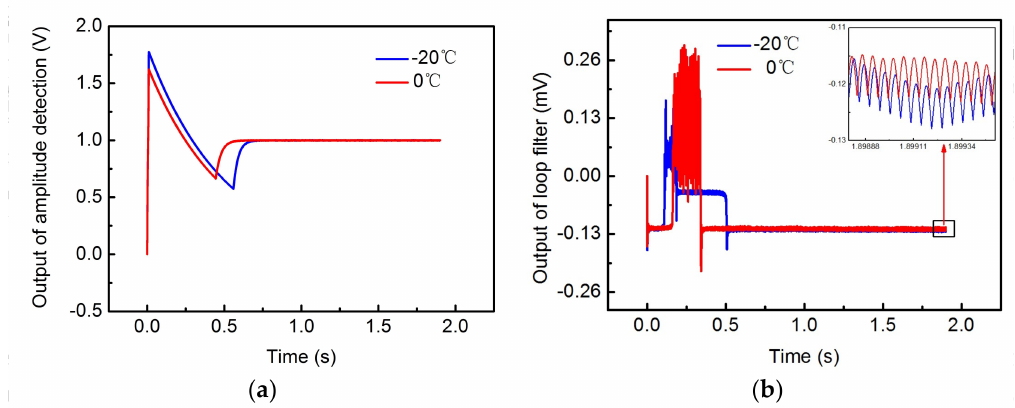
Figure 7. The closed-loop simulation results of drive mode: ( a ) the output voltage of amplitude detection at different temperatures ( b ) the output voltage of the loop filter at different temperatures.